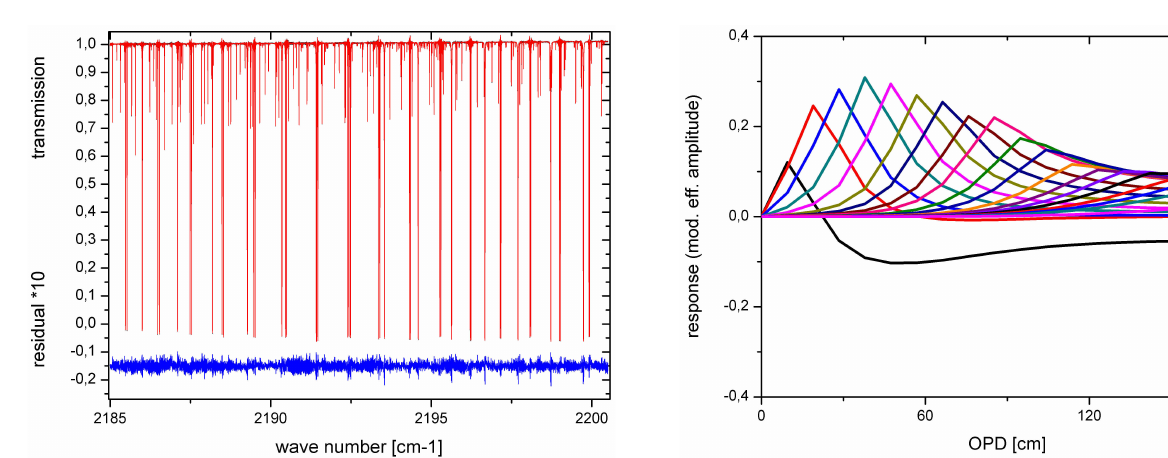
Fig. 5. A cell with 200mm effective path length filled with 100Pa N 2 O (cell C1) generates a useful spectral scene which contains both saturated and unsaturated lines. The figure shows the transmission spectrum provided by such a cell (black curve) and a LINEFIT cal- culation superimposed on it (red curve). The residual is shifted and magnified by a factor of 10 (blue curve). The spectrum was recorded on 26 July 2011.